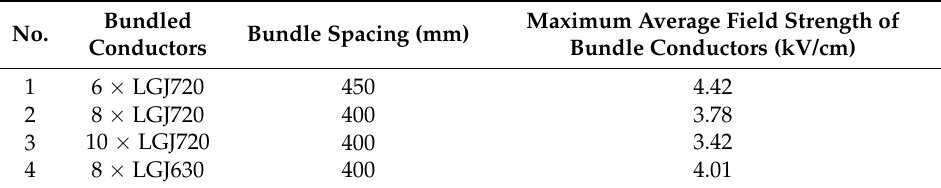
Table 2. Field strength of bundled conductors in the UHV corona cage.